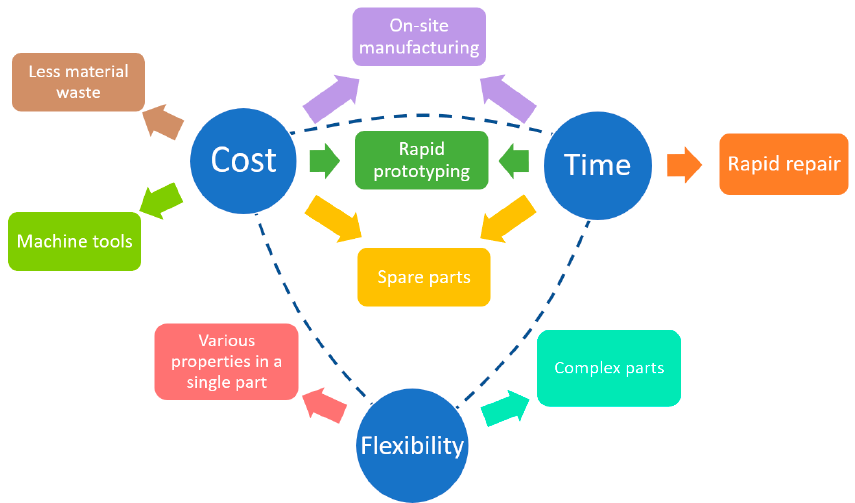
Figure 4. The interrelation between the three key features and additive manufacturing (AM) advantages.